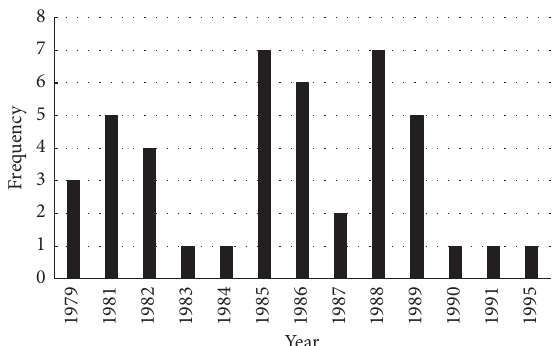
Figure2:Thefrequencydistributionofthechangepointsforannual mean temperature in 44